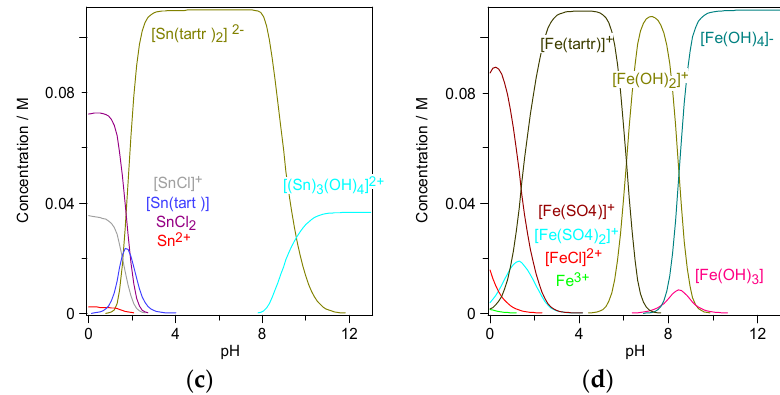
Figure 1. Calculated electrolyte speciation from the pH value 0 to 13: ( a ) Supporting electrolyte, without any metal ions, ( b ) Sn (0.11 M) single metal electrolyte, ( c ) Sn(II) species in the mixed Fe(III)–Sn(II) electrolyte, and ( d ) Fe(III) species in the mixed Fe(III)–Sn(II) electrolyte.